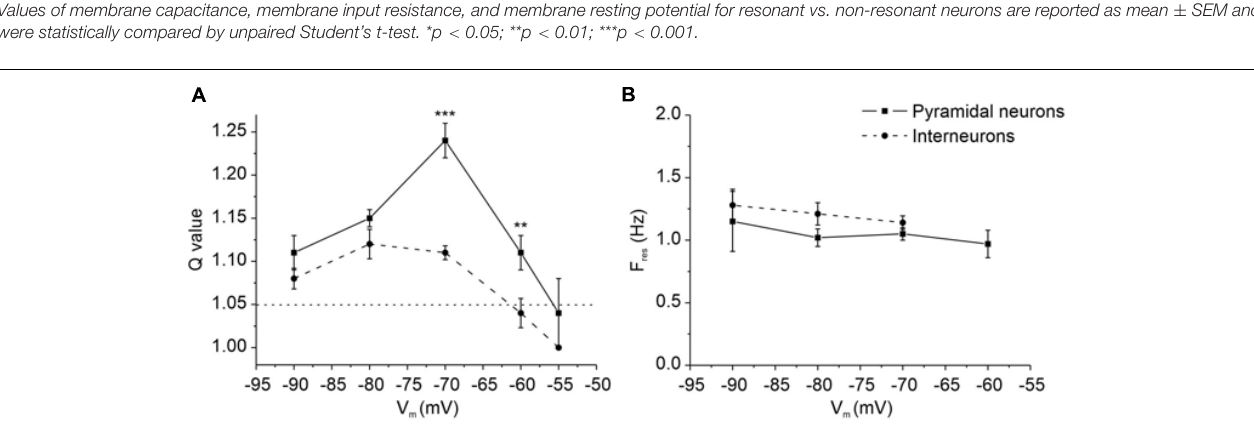
FIGURE 7 | Resonance properties of PRC pyramidal neurons and GABAergic interneurons at different membrane potentials. (A) Average Q values at different membrane potentials for pyramidal neurons (solid line) and GABAergic interneurons (dashed line). Q -value is defined as the ratio of impedance magnitude at F res and 0.1 Hz and is used to highlight the strength of the resonance. Dotted line at Q = 1.05 discriminates between absence ( Q -value < 1.05) and presence ( Q -value ≥ 1.05) of resonance. On average, pyramidal neurons show a significantly higher Q -value at –60 and –70 mV ( N = 35 and N = 99, respectively) compared to GABAergic interneurons recorded at the same membrane potentials ( N = 15 and N = 37, respectively) (** p < 0.01; *** p < 0.001; unpaired Student’s t -test). Moreover, among pyramidal neurons the mean Q -value was greater at –70 mV ( N = 99) compared to the most of other tested potential [–55 mV ( p < 0.01, N = 5), –60 mV ( p < 0.001, N = 35), –80 mV ( p < 0.001, N = 40); Kruskal-Wallis followed by Dunn’s multiple comparisons test]. Among interneurons the mean Q -value was lower at –60 mV ( N = 15) compared to –70 mV ( p < 0.001, N = 37) and –80 mV ( p < 0.01, N = 12) (Kruskal-Wallis followed by Dunn’s multiple comparisons test). (B) Average F res at different membrane potentials for pyramidal neurons (solid line) and GABAergic interneurons (dashed line). The mean values of F res are similar between pyramidal neurons [–60 mV ( N = 21), –70 mV ( N = 99), –80 mV ( N = 38) and –90 mV ( N = 8)] and GABAergic interneurons [–70 mV ( N = 37), –80 mV ( N = 12), –90 mV ( N = 9)] at all tested potentials (unpaired Student’s t